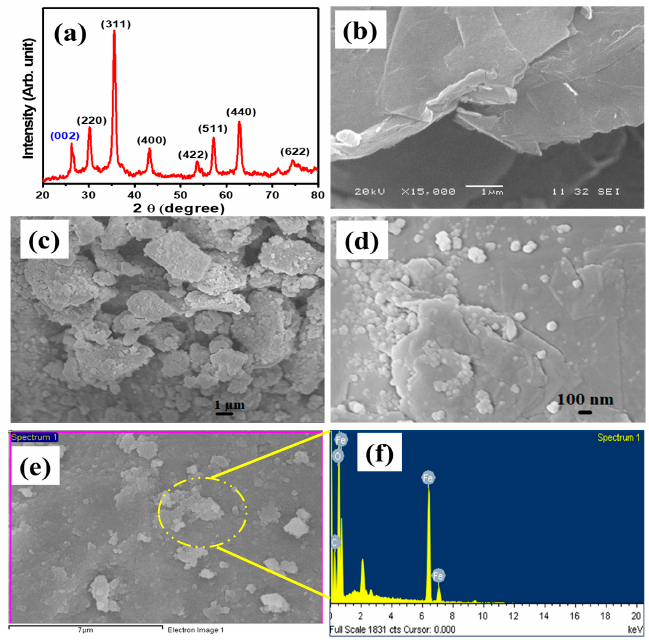
Figure 1. ( a ) XRD pa tt ern of Fe 3 O 4 /Gr nanocomposite, ( b ) SEM image of graphene, ( c , d ) SEM image of Fe 3 O 4 /Gr nanocomposite, ( e , f ) SEM image and EDS